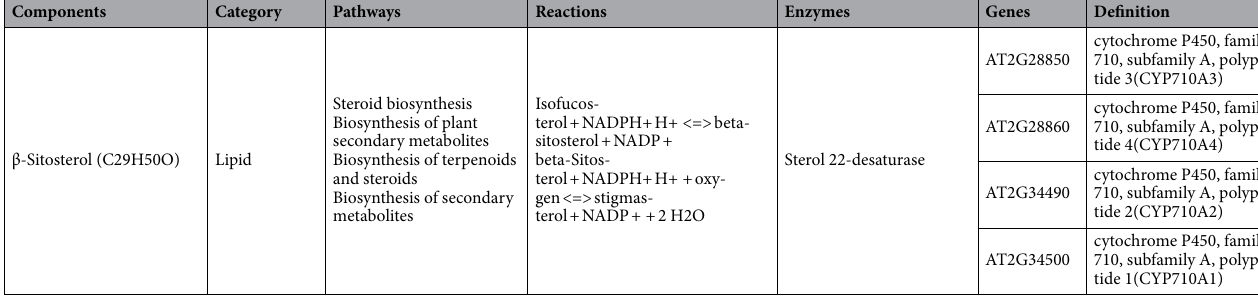
Table 3. Milk thistle lipids and their category, pathways, reactions, enzymes, genes and definitions.